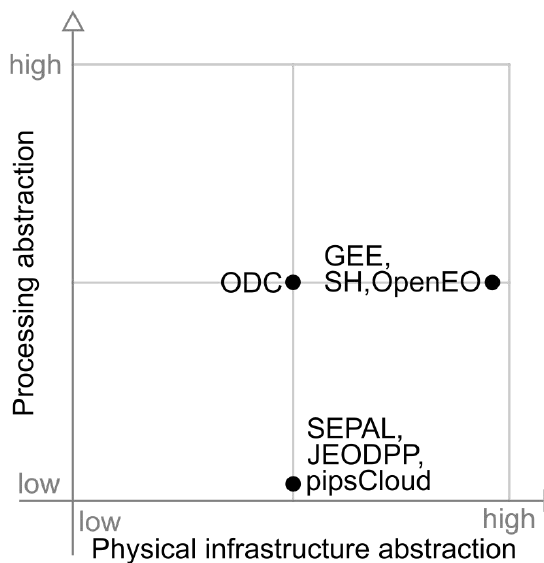
Figure 9. Physical infrastructure abstraction vs. Processing abstraction.